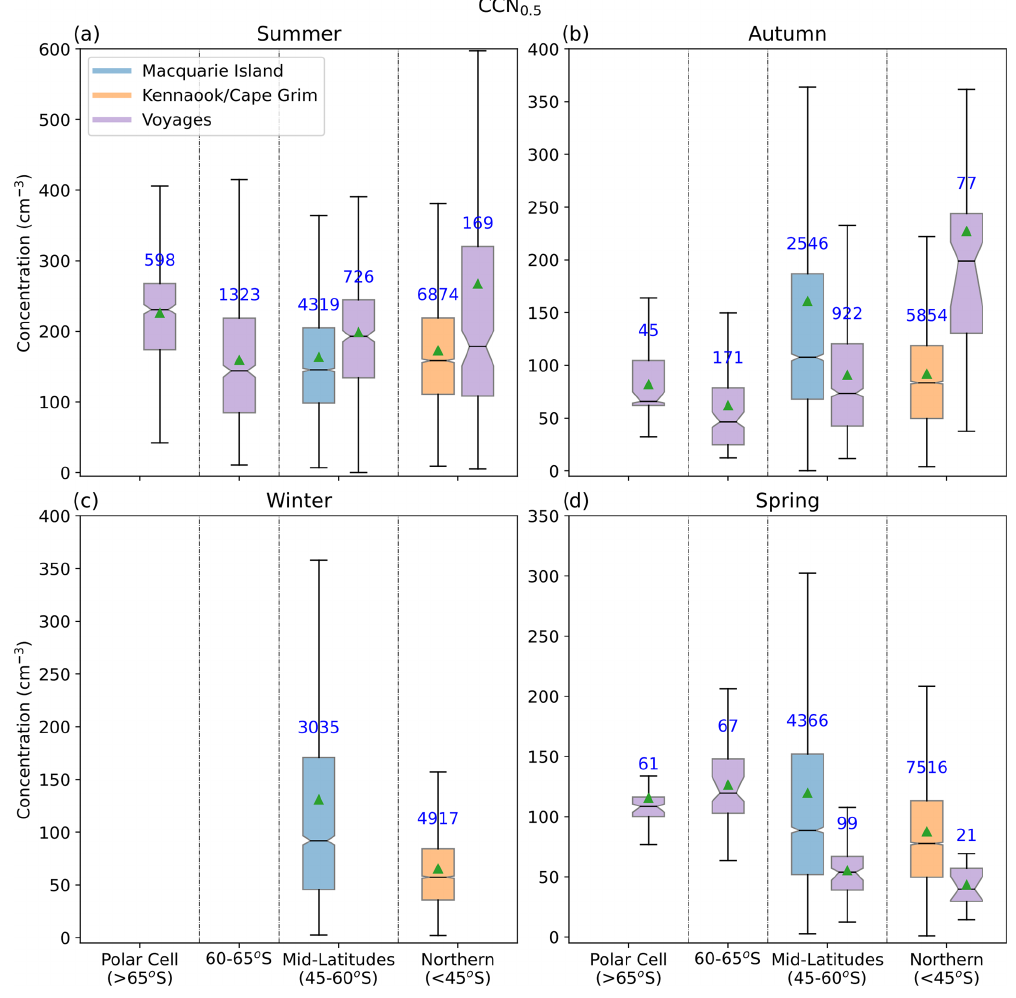
Figure 5. As in previous figure but for CCN 0 . 5 . A similar figure is shown in Fig. A7 with all y axis limits kept the same.